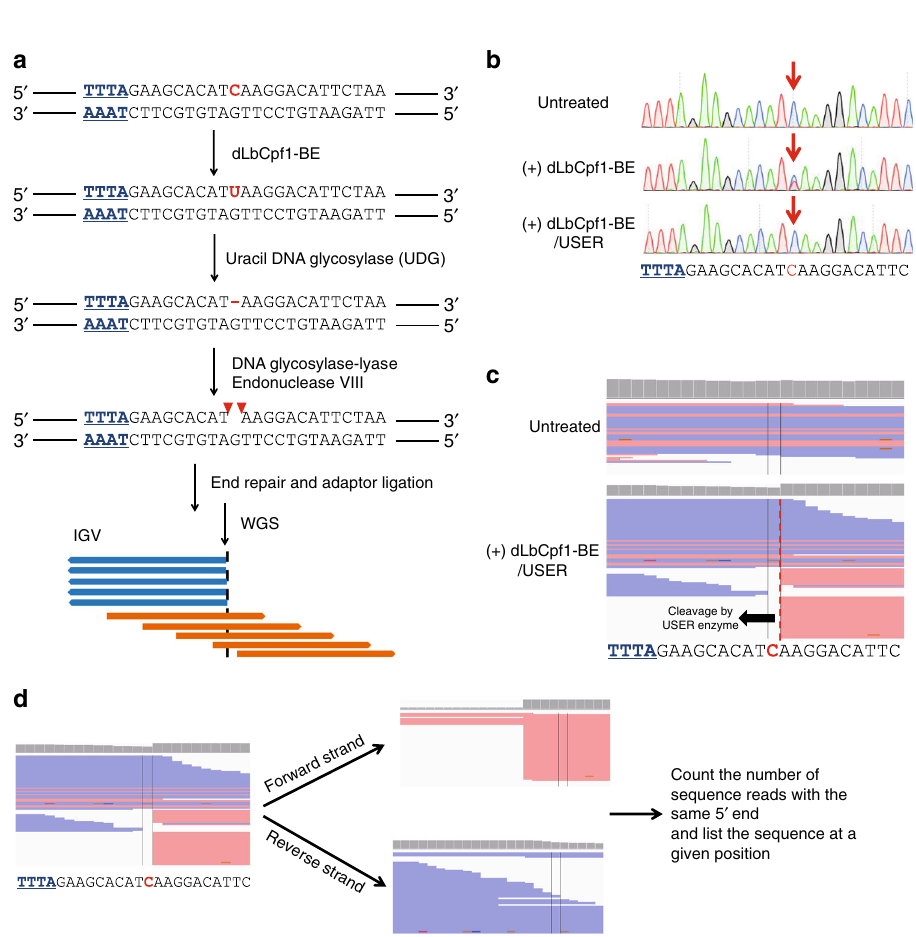
Fig. 2 Determination of the genome-wide speci fi city of dLbCpf1-BE using Digenome-seq. a Overview of dLbCpf1-BE-mediated Digenome-seq. Genomic DNA is incubated with dLbCpf1-BE, which converts C-to-U within the base editing window. A single nucleotide gap is generated by treatment with USER, a mixture of UDG and DNA glycosylase-lyase Endonuclease VIII. UDG recognizes and removes a uracil base to form an abasic site, shown as a red dash. DNA glycosylase-lyase Endonuclease VIII breaks the phosphodiester backbone of the abasic site, forming a DNA SSB as indicated with the red arrowheads. The dLbCpf1-BE- and USER-treated DNA is then subjected to WGS to evaluate the genome-wide speci fi city of dLbCpf1-BE. b Representative Sanger sequencing results showing dLbCpf1-BE-induced C-to-U conversion and USER-induced uracil excision. The position of the sequence change is indicated by the red arrows. c IGV images showing straight and staggered alignments of sequence reads at the DYRK1A on-target site obtained using WGS. d Work fl ow of WGS analysis to capture genome-wide SSB sites. Sequence reads are divided into forward and reverse strands according to the read orientation. The number of sequence reads with 5 ′ ends at each position are then counted for each set of strands to pro fi le off-target mismatch number of 8 as the cutoff value at PAM (5 ′ -TTTN-3)- reproducibility of Digenome-seq, we independently performed containing sites, which is a less strict parameter than that used in other genome-wide Cpf1 off-target pro fi ling methods such as and found that the same 17 sites including the on-target site were GUIDE-seq (allowing for up to seven mismatches) 18 and BLISS captured by the two different experiments (Supplementary Fig. 3; (allowing for up to four mismatches) 19 , because WGS data Supplementary Table 2). These experiments established that we obtained with intact genomic DNA did not show any false- could identify dLbCpf1-BE off-target sites using Digenome-seq positive sites with eight or fewer mismatches (Supplementary with high reproducibility. Table 1). Using these bioinformatics analyses, we identi fi ed 20 potential off-target sites, in addition to the on-target site, by modi fi ed Digenome-seq using dLbCpf1-BE with a crRNA targeting DYRK1A (Supplementary Table 2). To check the